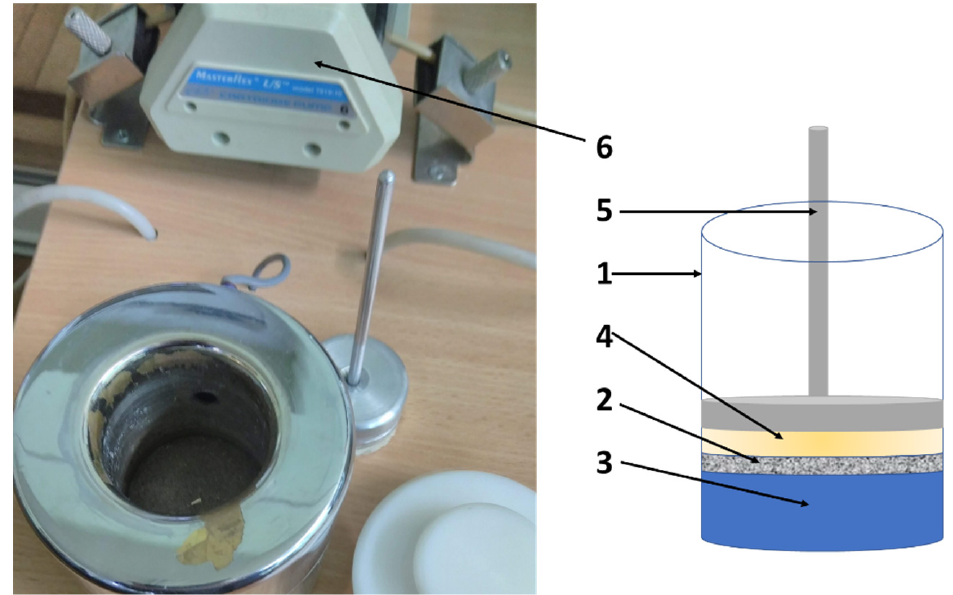
Figure 5. General view of the SORB 3 measuring instrument. 1—measurement chamber, 2—Schott plate, 3—regulating system sets the liquid level, 4—sample and 5—holder.